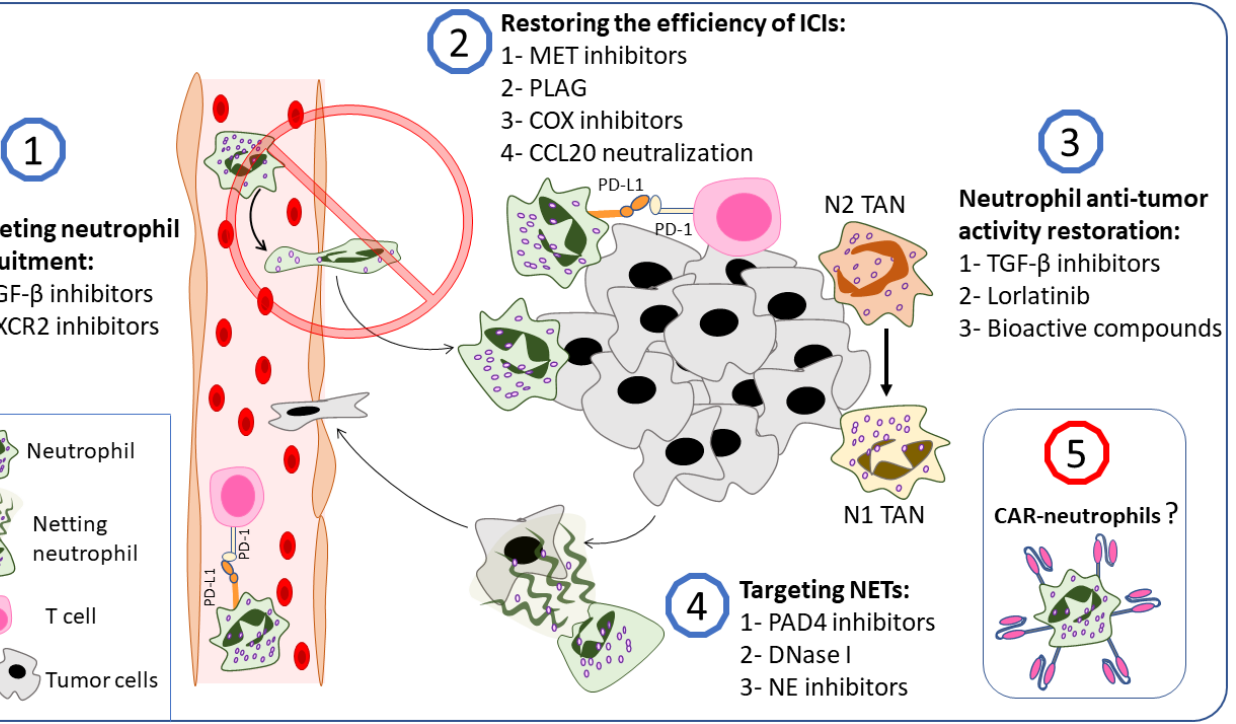
Figure 4. Neutrophil in cancer therapy: potential approaches. Several neutrophil-based anticancer therapies have recently been investigated: ( 1 ) A suggested strategy is to inhibit neutrophil recruitment to the tumor microenvironment. TGF- β and CXCR2 inhibition is the first strategy that comes to mind, since they are widely involved in neutrophil recruitment to the tumor microenvironment [26,236]. More promising strategies are to block neutrophil immunosuppressive function or to restore neutrophil anti-tumor properties. ( 2 ) MET inhibitors [83], PLAG [237], COX inhibitors [238], and CCL20 inhibitors [123] could inhibit neutrophil immunosuppressive functions and restore the efficiency of ICIs. ( 3 ) To restore neutrophil anti-tumor activities, TGF- β inhibitors [14], lorlatinib [233], and some selected bioactive compounds (berberine [239], salidroside [240], and emodin [241]) are considered reliable choices. ( 4 ) NET inhibition is also a potential therapeutic approach that could be applied by the inhibition of NET production (PAD4 inhibitors [235]), the digestion of NETs (DNase I [235]), or the inhibition of different NET compounds (NE inhibitors [169]). ( 5 ) Recently, CAR-neutrophils were developed as a novel approach to use neutrophils in cancer therapy [17]. TGF- β — transforming growth factor beta, CXCR—CXC chemokine receptor, PD-L1—programmed death-